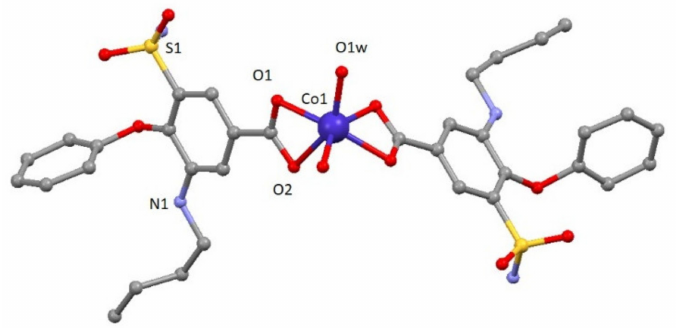
Figure1. Aperspectiveviewonthemolecularstructureof[Co(bum) 2 (H 2 O) 2 ].(H 2 O) 2 ( 1 ). Crystallization water molecule and hydrogen atoms have been omitted for